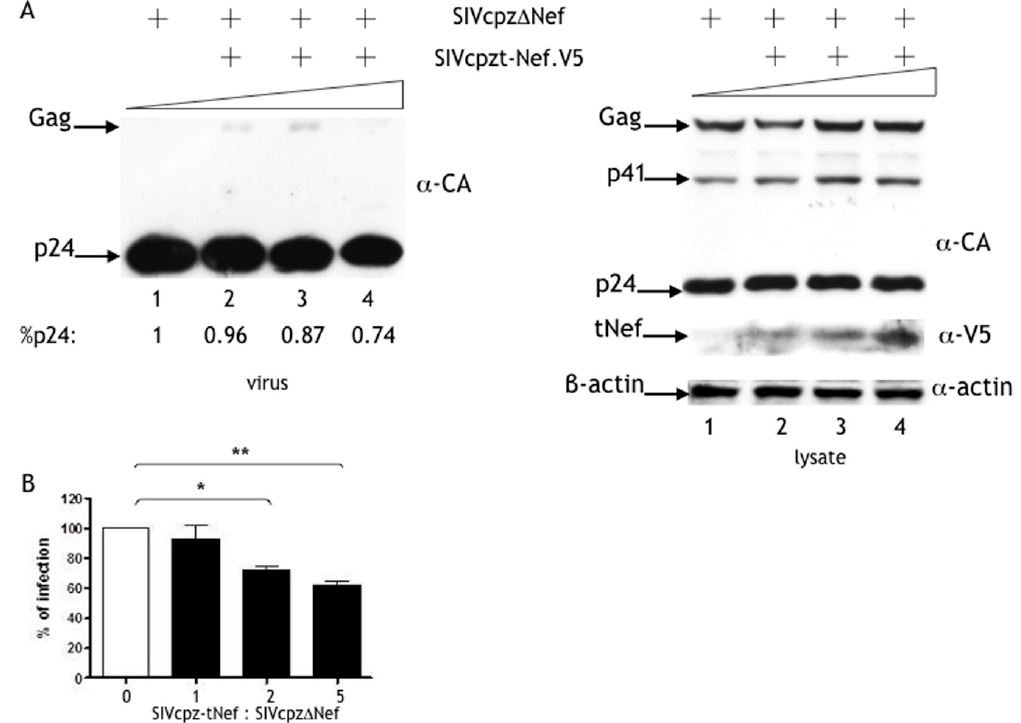
Figure 3. The processing defect and the loss of infectivity of SIVcpz-tNef is due to the tNef peptide. Hek-293T cells were co-transfected with SIVcpz ∆ Nef provirus DNA and the pcDNA.tNef.V5 vector at different ratios (1:0, 1:1, 1:2 and 1:5). Differences in the amount of plasmid DNA in each transfection were compensated by the addition of an empty vector. ( A ) Western blot of concentrated viral particles and cell lysates using polyclonal α -CA, monoclonal α -V5 for the expression of the tNef peptide conjugated to V5 epitope in cell lysates, and α - β -actin as the loading control. Lanes 1–4 are representative of the 1:0, 1:1, 1:2 and 1:5 ratios of SIVcpz ∆ Nef to pcDNA.tNef.V5 vectors, respectively; ( B ) supernatants were used in infectivity assays with the TZM-bl and the number of infected cells was counted and represented as the percentage of the SIVcpz ∆ Nef control (* p = 0.011; ** p = 0.005). Results represent three independent